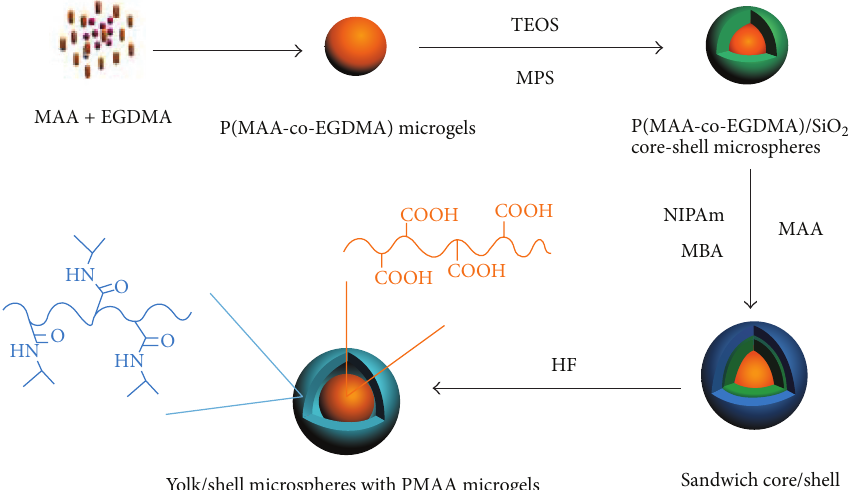
Figure 9: Schematic illustration of the fabrication process of the multifunctional yolk/shell microspheres for controlled microspheres for controlled release of drug from the sandwich core/shell microspheres with sacrificial SiO 2 interlayer (reproduced from [109], with permission from American Chemical